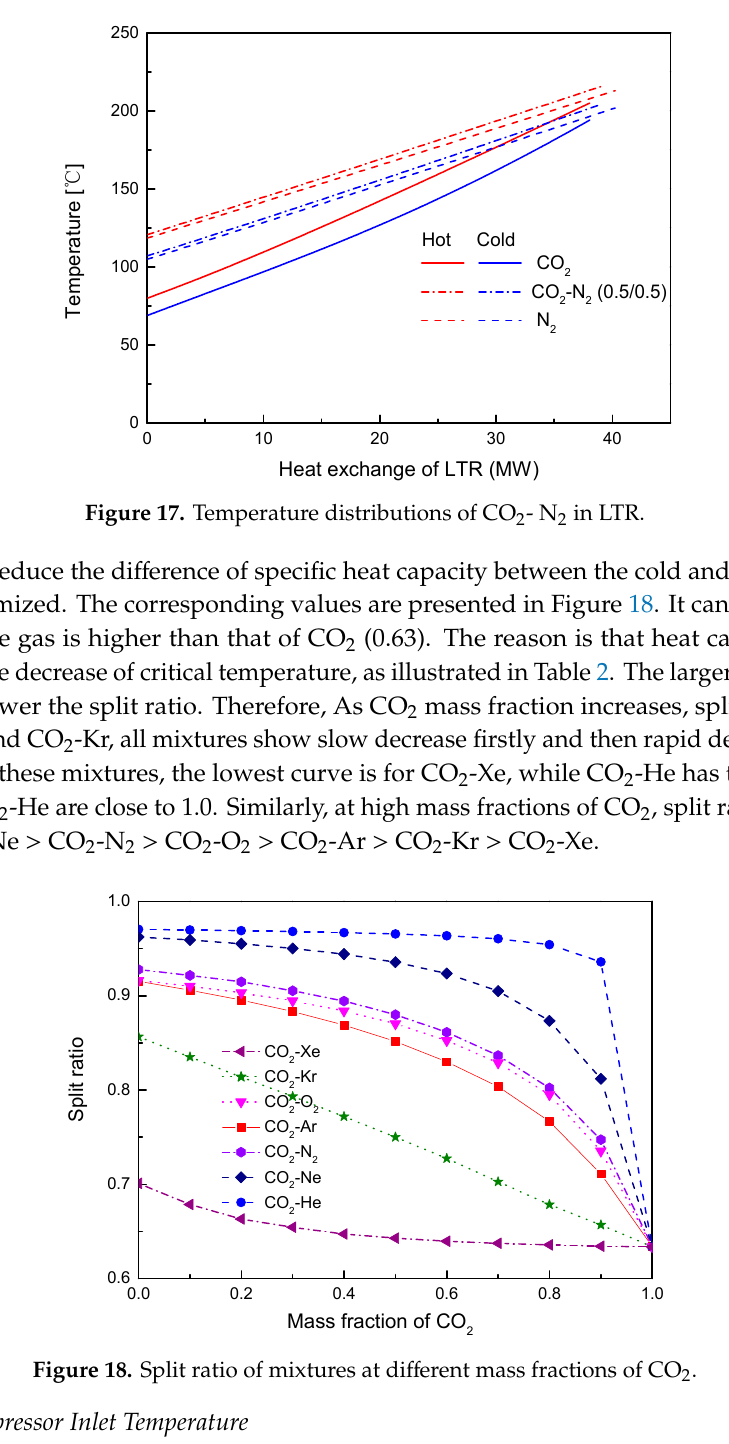
ff erent mass fractions of CO 2